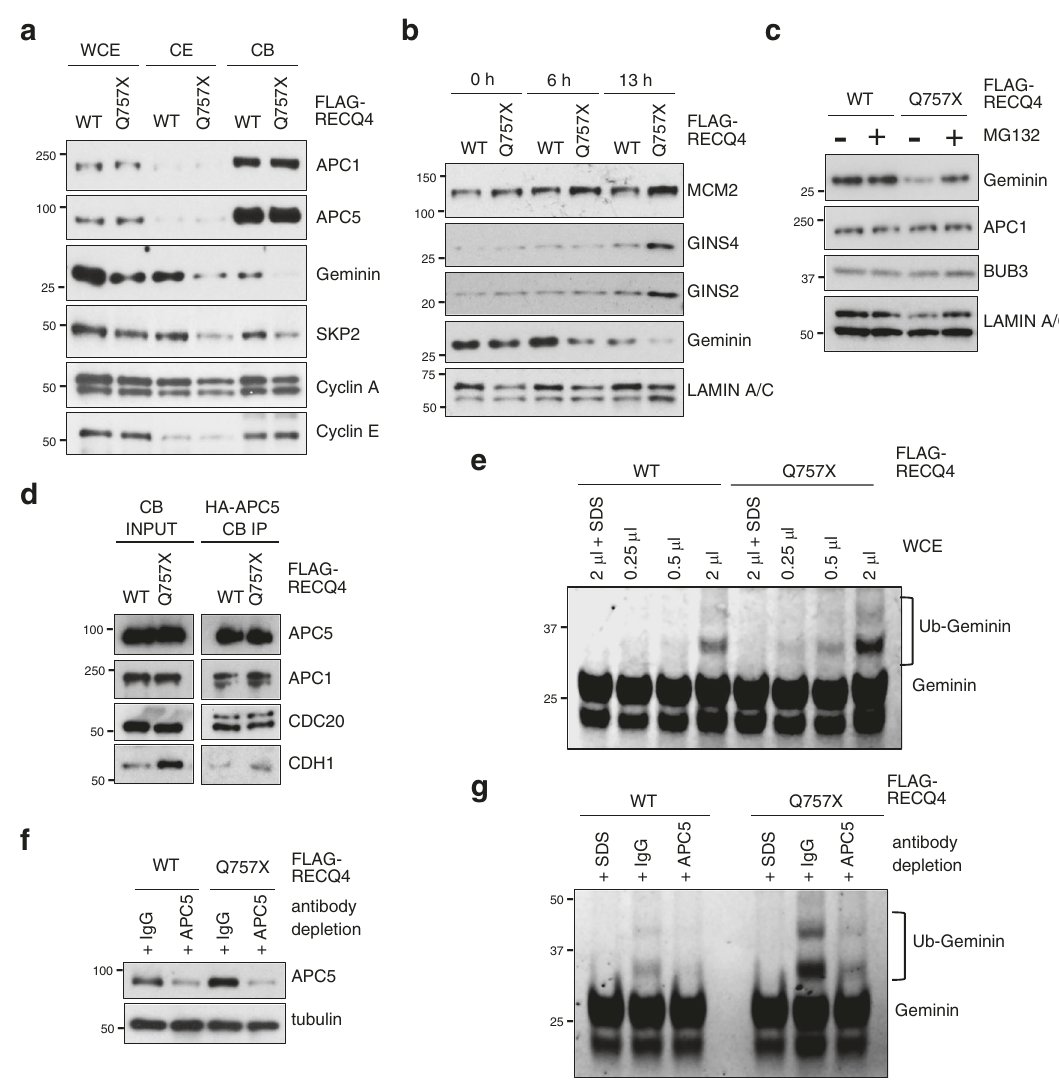
Fig. 6 | RECQ4 enhances APC/C E3 ubiquitin ligase activity. a Representative western blot analysis of the indicated proteins in whole-cell extracts (WCE), cyto- plasmic (CE), and chromatin-bound (CB) fractions prepared from RECQ4 knock- down (KD) HEK293 cells stably expressing FLAG-tagged RECQ4 wild type (WT) or Q757X mutant protein. b Representative western blot analysis of the indicated proteins in CB fractions prepared from RECQ4 WT or Q757X mutant expressing cellsattheindicatedtimepointspost-nocodazolerelease.LAMINA/Cwasusedasa loading control. c Representative western blot analysis of the indicated proteinsin CB fractions prepared from RECQ4 WT or Q757X mutant expressing cells with or without MG132 treatment to inhibit proteasome activity. LAMIN A/C was used as a loading control. d Representativewesternblot analysisof the indicatedproteinsin CB fractions (left) and in immunopuri fi ed APC5 protein complexes from the CB